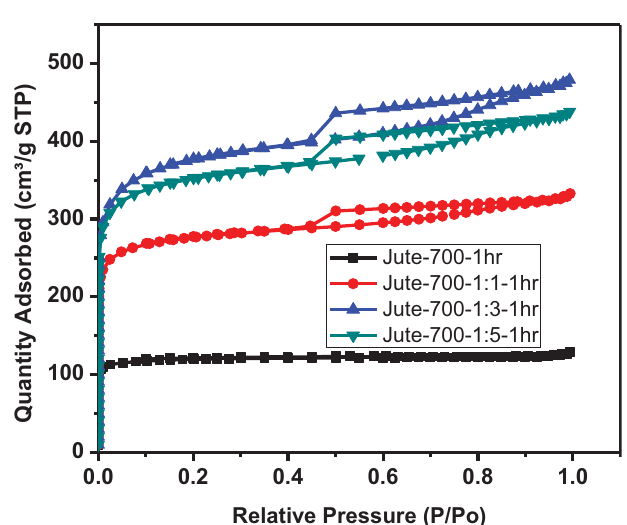
Fig. 3. Nitrogen adsorption isotherms of activated carbon at (cid:1) 196 ° C. Activated carbon weight =200 mg.